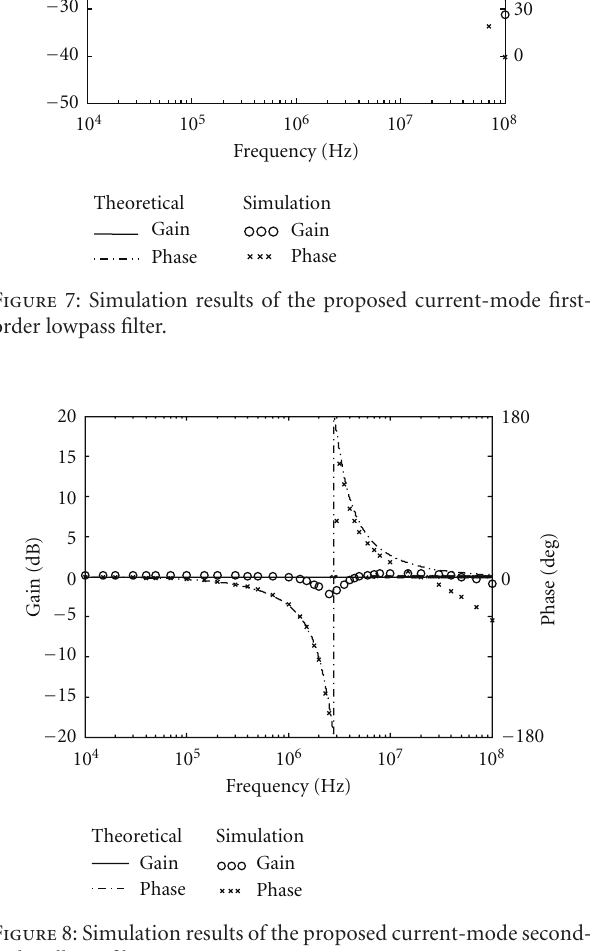
Figure 6: Simulation results of the proposed current-mode first- order highpass filter.